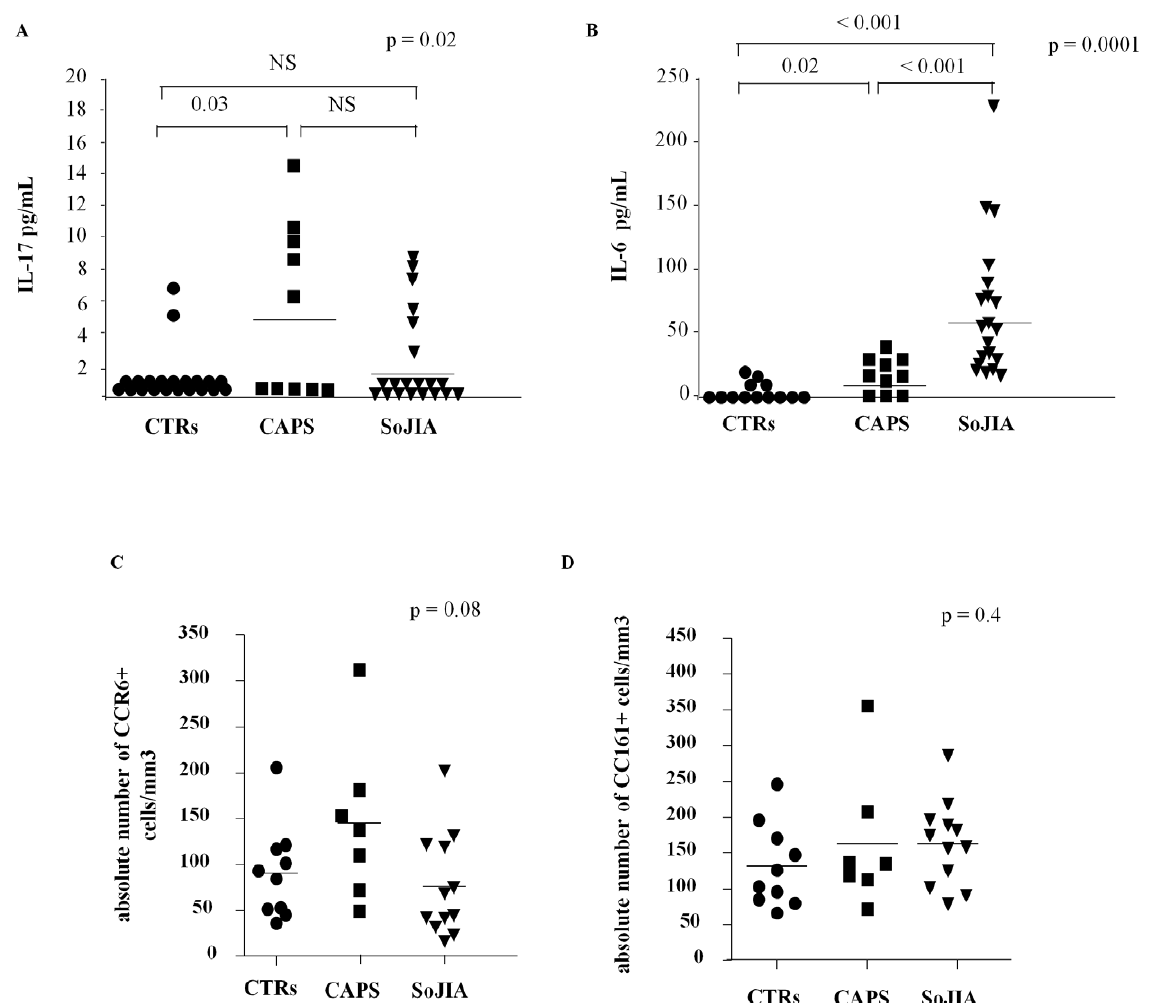
Figure 1. Analysis of IL-17 and IL-6 serum concentrations and peripheral CD4 + T cell phenotype. IL-17 (panel A) and IL-6 (panel B) serum levels were measured in 10 active CAPS patients, 20 active SoJIA patients and 20 healthy controls by ELISA. C–D) Ex-vivo analysis of circulating CCR6 + (panel B) and CD161 + (panel C) memory T cells (CD4 + CD45RA 2 ) in the same three subgroups. Heterogeneity test among groups was evaluated using the non parametric Kruskal-Wallis test (upper right of each graph). Post-hoc analysis with non-parametric U Mann-Whitney test revealed the difference among the three subgroups. doi:10.1371/journal.pone.0020014.g001 (Figure 1C) tent to be higher than that found in the other two subgroups, although the difference was not statistically significant.